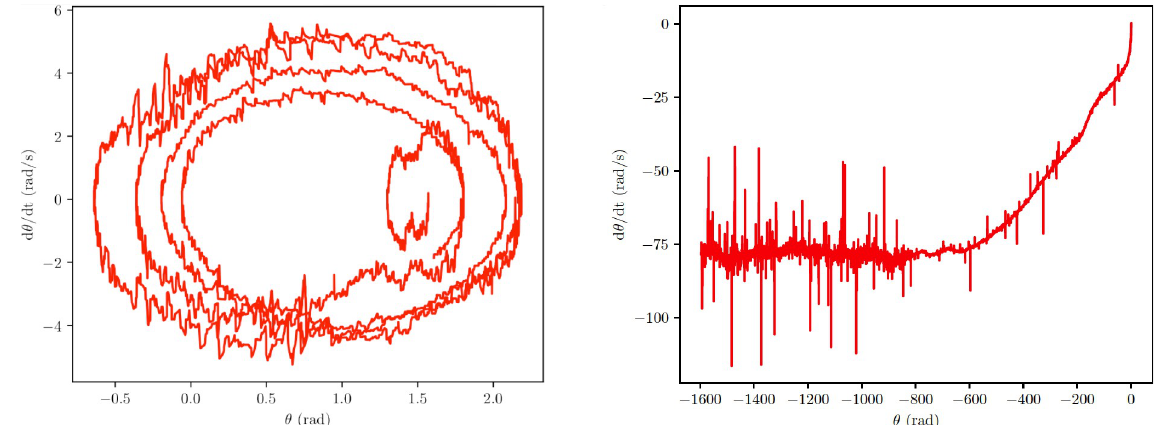
Fig 9. Phase portraits. Phase portrait of the propeller. As in the case of the simple pendulum, when the propeller does not rotate, e.g. at 65 Hz (left), the diagram shows the trend of a closed curve. In contrast, the trend of the diagram at 156 Hz is that of an open curve (right), due to the revolution of the propeller; the final stage of the run appears rather noisy, probably owing to nail/propeller shocks and relative slip, that sometimes may suddenly enhance friction forces and angular speed variations. Unfortunately, the backlash between the nail and the propeller turns out to be necessary to the onset of rotations, but it also makes the dynamics of the system far form being trivial.